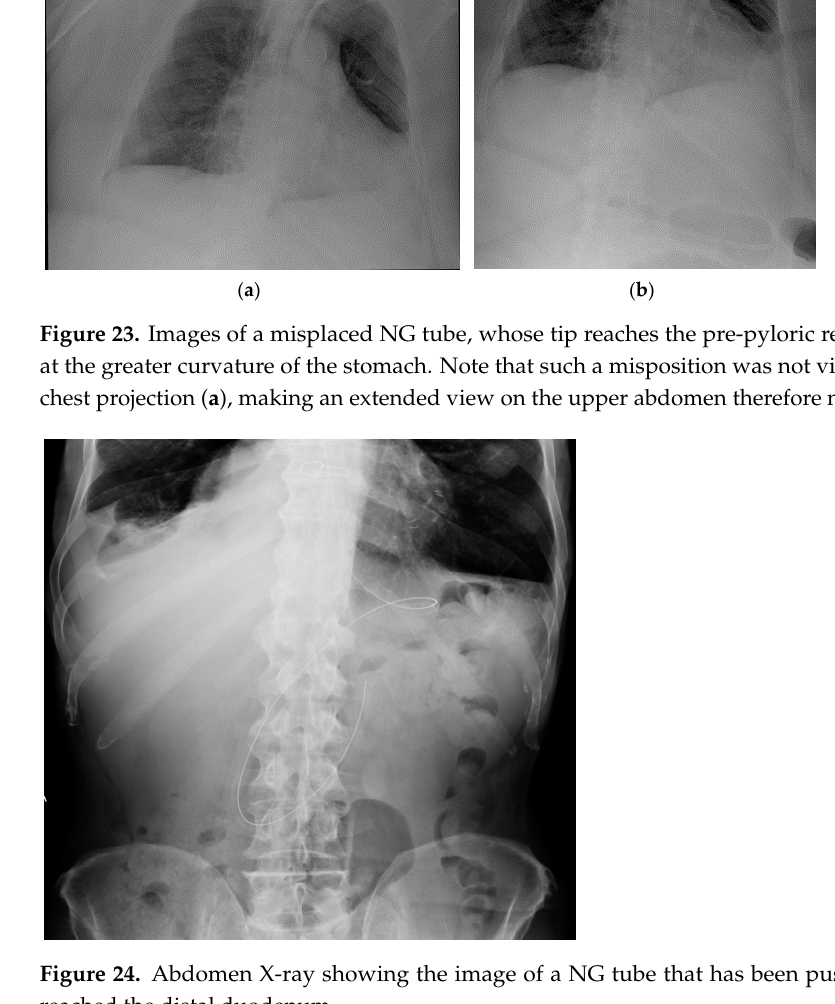
Figure 25. Abdomen X-ray showing the image of a NG tube projectively looping in the inferior mediastinum, due to a hiatal hernia; it is possible to also appreciate two metallic clips in the right hypochondrium and multiple air-fluid levels.